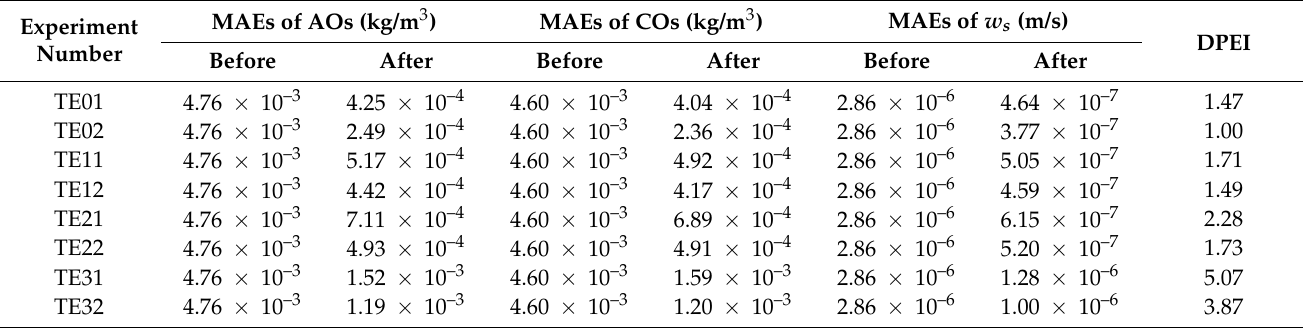
Table 2. Results of the normalized cost function, MAEs between AOs and the simulated SSCs, MAEs between COs and the simulated SSCs, MAEs between the prescribed and estimated settling velocity w s , and DPEI in the twin experiments.